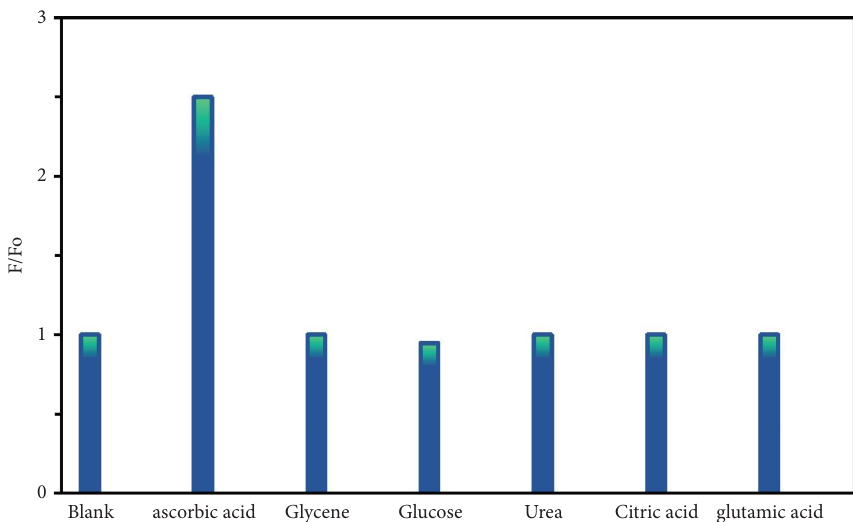
Figure 8: Selectivity of HP-CQDs for ascorbic acid.